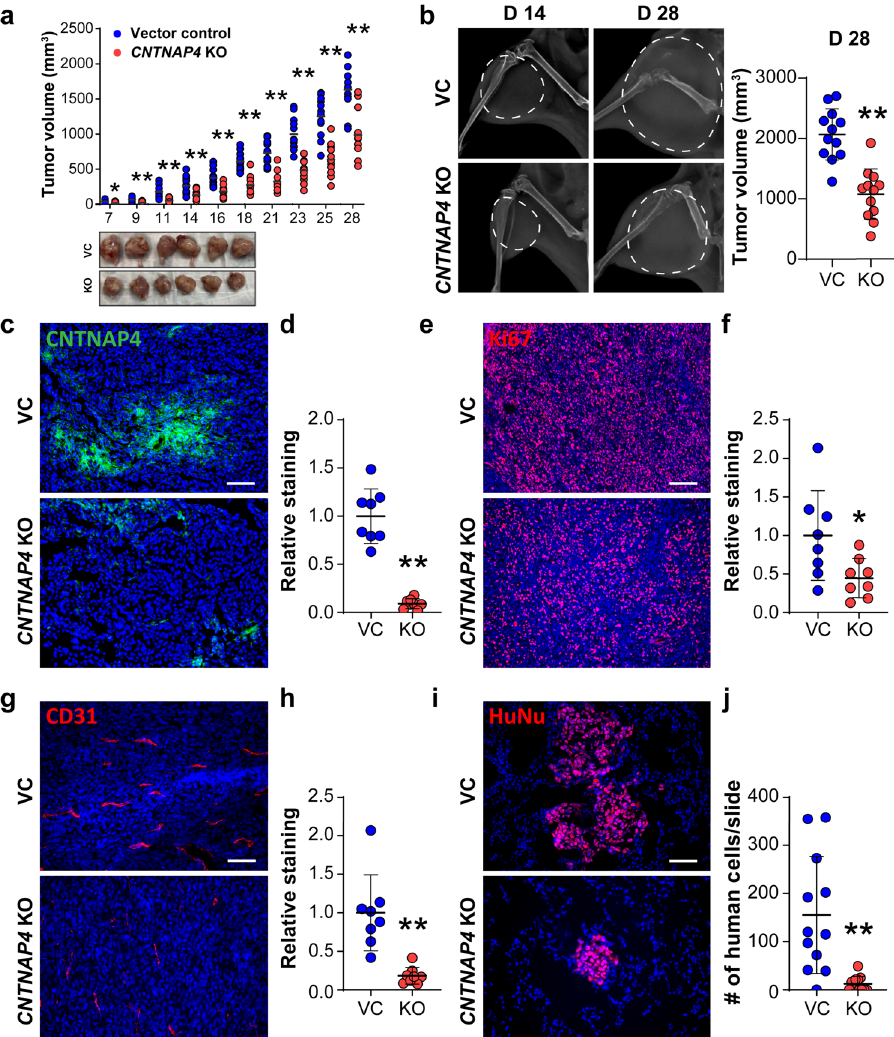
Fig. 2 CNTNAP4 knockout mitigates OS disease progression in 143B xenograft model. Orthotopic implantation of CNTNAP4 KO or vector control clonal 143B cells within the proximal tibia of female NOD-Scid mice ( n = 12 mice per group, 1 × 10 6 cells per implant). a Tumor volume, calculated by caliper measurements twice weekly until 28 days post-injection (top) and gross pathology of tumors (bottom). b Representative XR imaging at 14 and 28 days post-injection (left) and tumor volume (d28, right). White dashed line indicating tumors. c , d CNTNAP4 KO veri fi ed by ( c ) CNTNAP4 immunostaining and ( d ) quanti fi cation. e , f In vivo tumor proliferation assessed by ( e ) Ki67 immunostaining and ( f ) quanti fi cation. g , h Tumor-associated angiogenesis assessed by ( g ) CD31 immunostaining and ( h ) quanti fi cation. i , j Lung metastasis assessed by ( i ) Human Nuclei (HuNu) immunostaining on cross-sections of pulmonary fi elds and ( j ) quanti fi cation of metastatic cells. Data shown as mean ± 1 SD, with dots representing individual data points. P < 0.05; ** P < 0.01. Scale bars: 100 pJNK in ISO-treated CNTNAP4 KO cells (Fig. 4g, Supplementary Fig. 8). The activation of ERK1/2 signaling was next assessed by immuno fl uorescent staining for ERK1/2 and pERK1/2 across 143B xenografts. Among CNTNAP4 KO tissue sections, decreased pERK1/ 2 and retained ERK1/2 immunoreactivity was observed in comparison with control tumors (Fig. 4g).